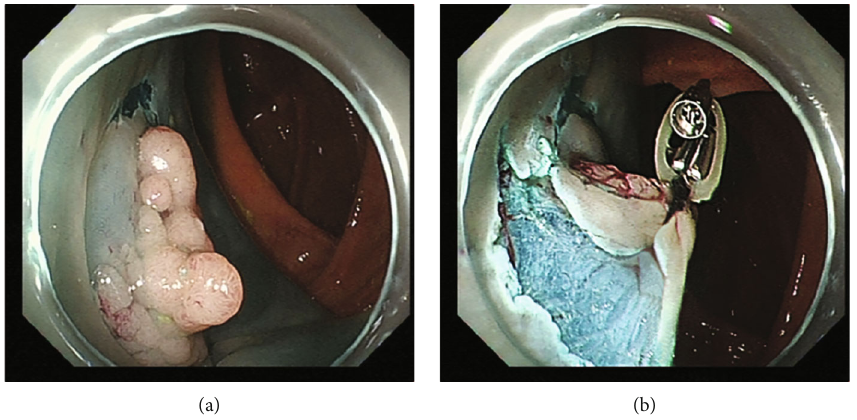
Figure 3: (a) An ascending colon lesion with the mucosal incision; (b) good traction e ff ect.